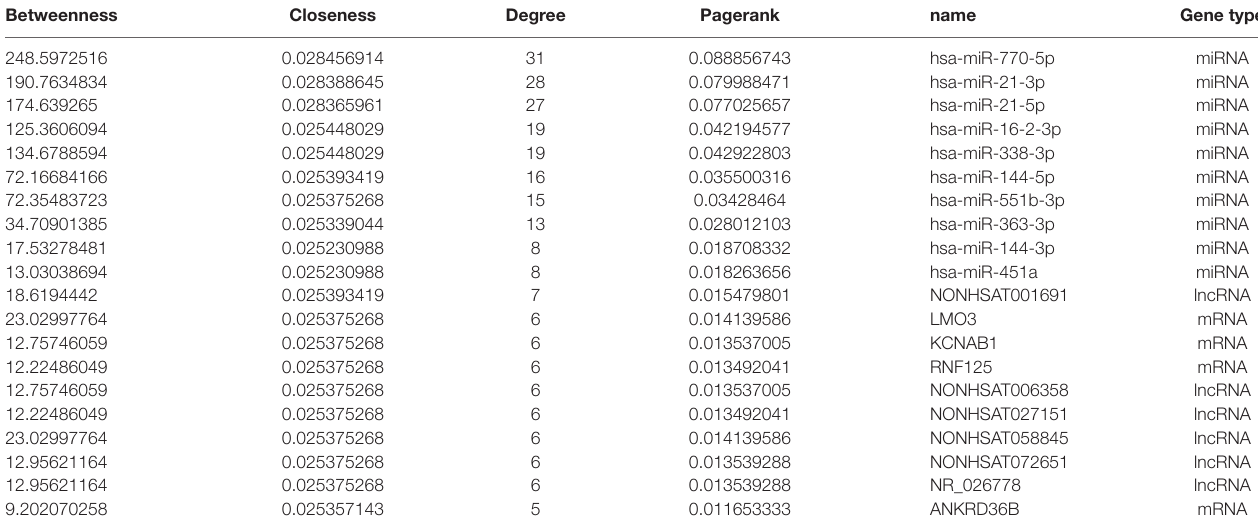
TABlE 2 | The top 20 genes in degree, betweenness and closeness. Betweenness Closeness